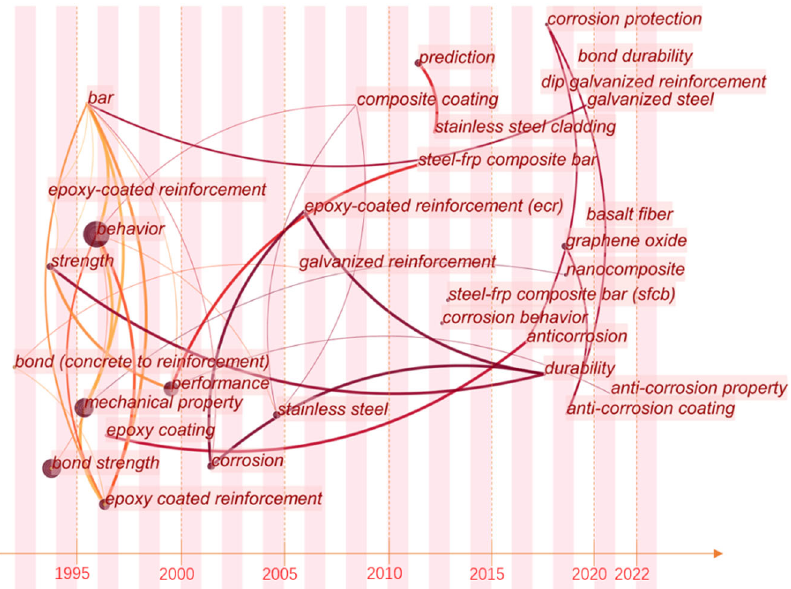
Figure 2. Combined frequency and centrality of keywords (the size of cycle and width of line represent the frequency and centrality).